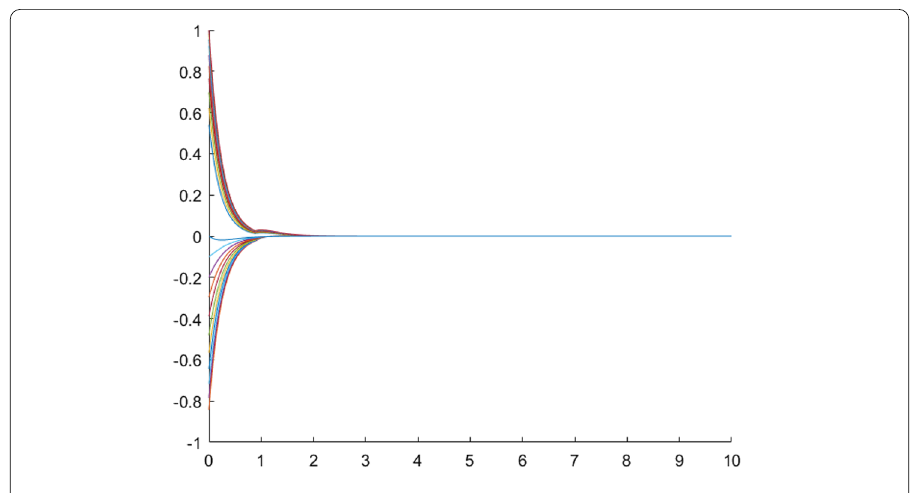
Figure 1 The simulation in the